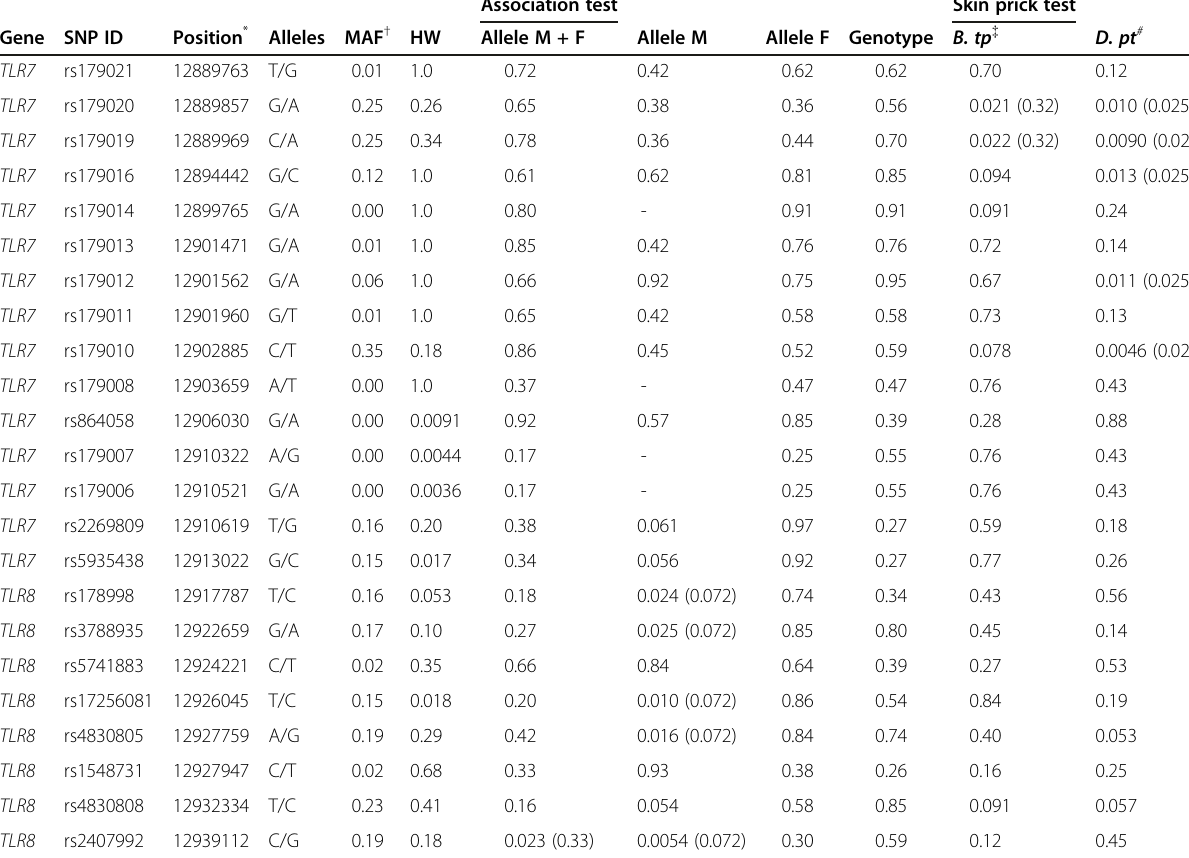
Table 3 Association of SNPs in the TLR7-TLR8 region with AR phenotype in the Chinese population Association